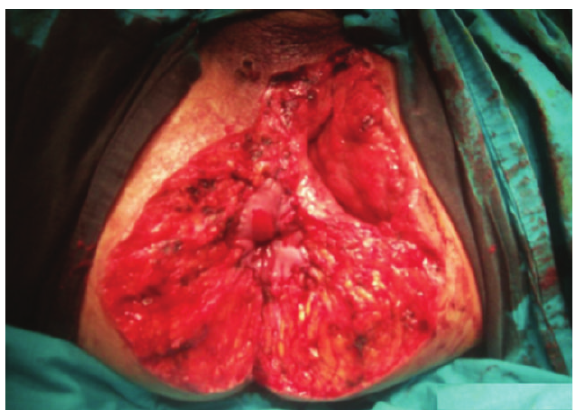
Figure 2: Image of the perianal region after the excision of the mass.